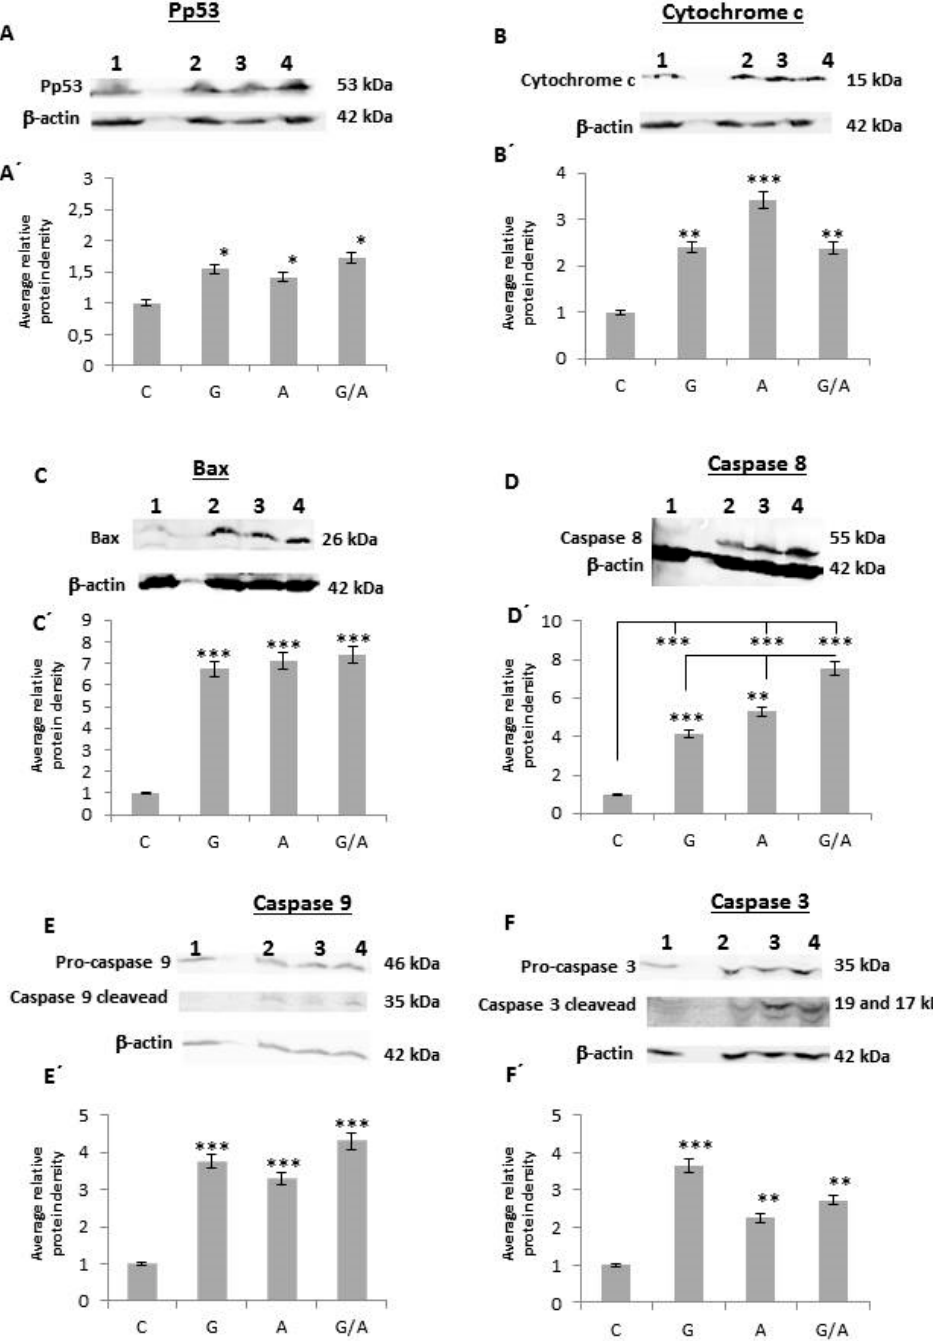
Figure 5. Western blot analysis of ( A ) Pp53, ( B ) caspase 8, ( C ) cytochrome c, ( D ) Bax, ( E ) caspase 3, ( F ) caspase 9. Line 1. Control DLD-1, line 2. DLD1/Tet-On- gef , line 3. DLD1/Tet-On- apoptin , line 4. DLD1/Tet-On- gef - apoptin . Relative quantification of the western blot proteins normalized with β -actin signal and relative to mock-treated cells (value 1) ( A ’, B ’, C ’, D ’, E ’, F ’). Data expressed as a mean ± SD from three independent experiments performed in duplicate (* p < 0.05 vs. control, ** p < 0.01 vs. control and *** p < 0.001 vs. control).